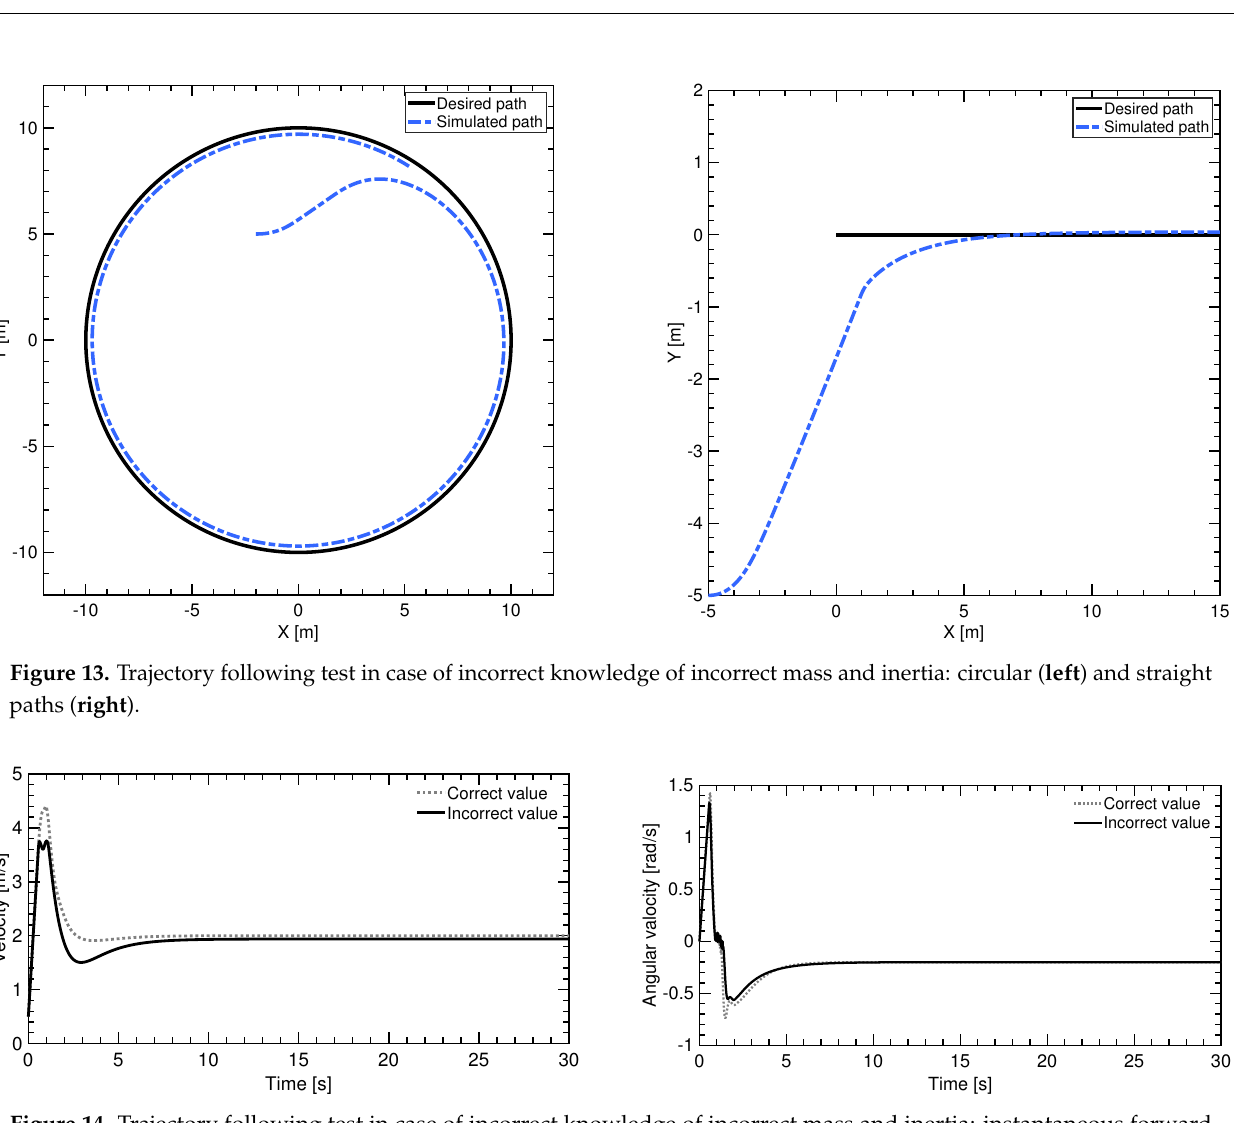
Figure 14. Trajectory following test in case of incorrect knowledge of incorrect mass and inertia: instantaneous forward velocity ( left ) and rotational velocity( right ).